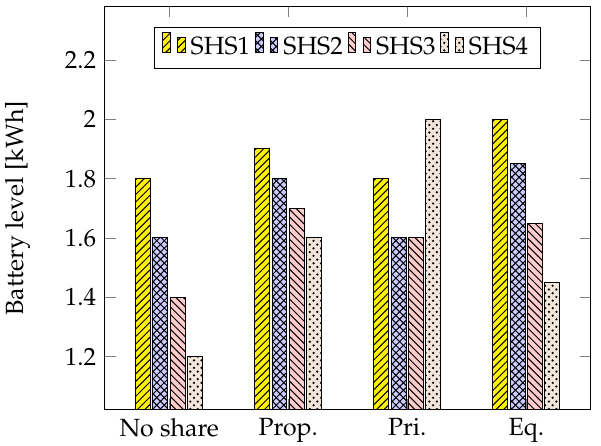
Figure 7. Battery energy levels for the 4 SHS batteries without sharing and after the combined excess energy distribution based on proportional (Prop.) energy sharing, priority (Pri.) energy sharing, and equal (Eq.) energy sharing. The rated battery capacity is also shown as the dashed line in the